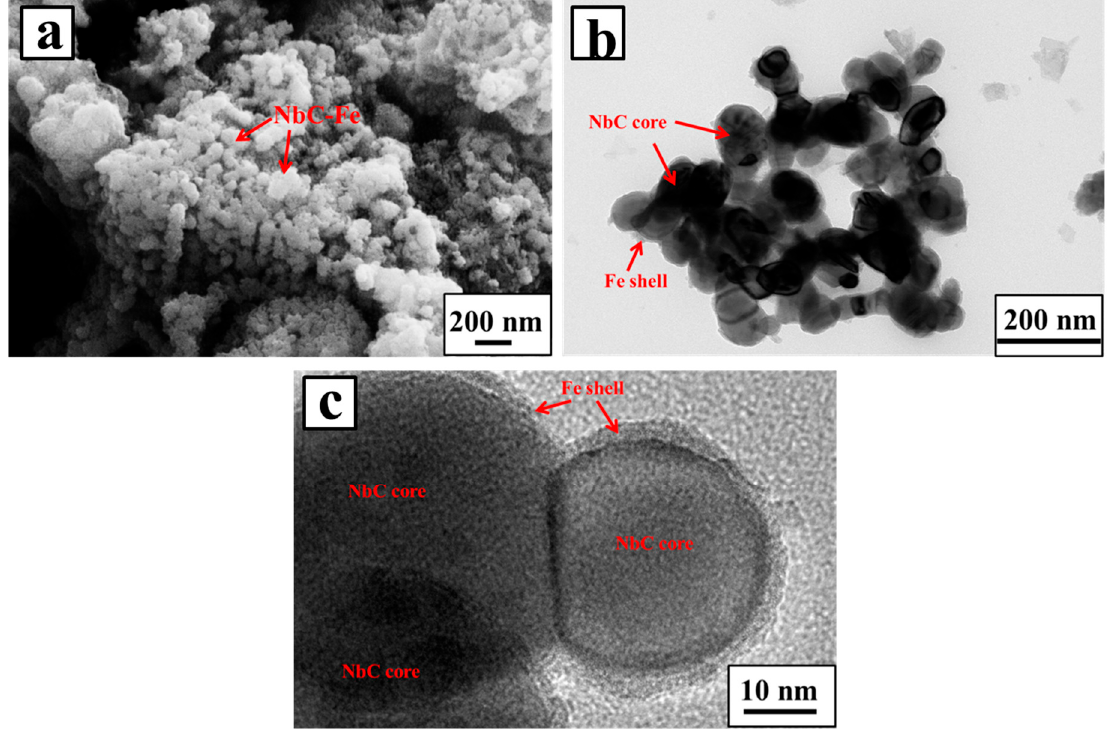
Figure 5. ( a ) SEM image; ( b ) transmission electron microscope (TEM) image; and ( c ) HRTEM image of the samples electrochemically reduced from the Nb 2 O 5 /Fe/carbon composite pellets under 3.0 V for 10 h at 900 °C.